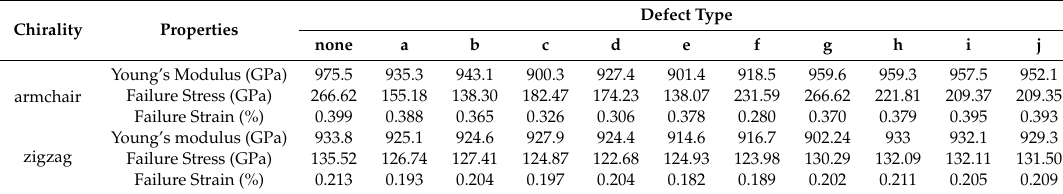
Figure 13. ( a ) Young’s modulus, ( b ) failure stress, and ( c ) failure strain of defective C 3 NNTs at 300 K Table 8. Mechanical properties of defective SWC 3